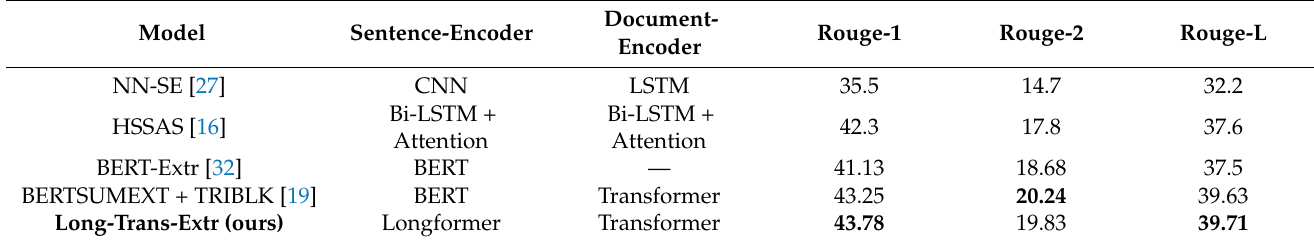
Table 3. The comparison between our Long-Trans-Extr model and other extractive models, with the same decoder, on CNN/DailyMail